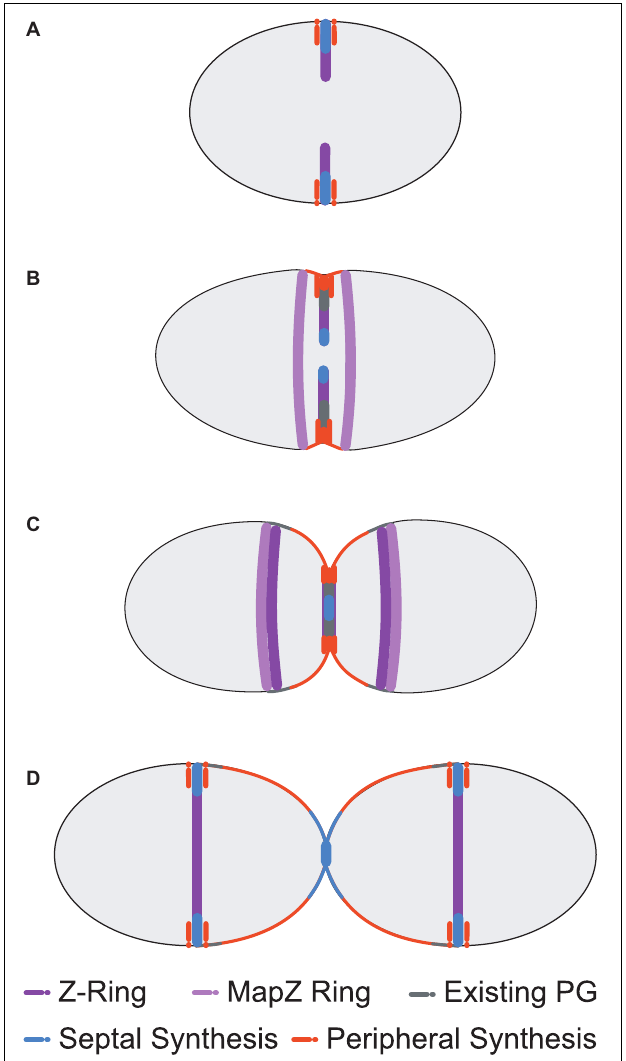
FIGURE 1 | Pneumococcal cell division morphology. Following the initial formation of the Z-ring and divisome machinery, septal and peripheral PG synthetic complexes begin to make new PG as invagination begins (A) . Two concentric rings of newly synthesised PG surrounding the existing sacculus form as a result, whilst a portion of MapZ, FtsZ, EzrA, and FtsA (MapZ Ring) begin to migrate to the new equators. For simplicity, newly synthesised peripheral PG is drawn as a single orange colour, but likely consists of some mixture of newly synthesised peripheral PG attached to remodelled septal PG (see Trouve et al., 2021) (B) . Septal PG synthesis continues to close the central septum whilst peripheral PG synthesis continues to elongate the cell from midcell (C) . This process continues until the septum is closed. The divisome machinery then migrates to the midcells of the newly formed daughter cells and the cycle repeats (D) . Note that pneumococcus exists natively as encapsulated cells that are often in chains of divided cells (Barendt et al.,